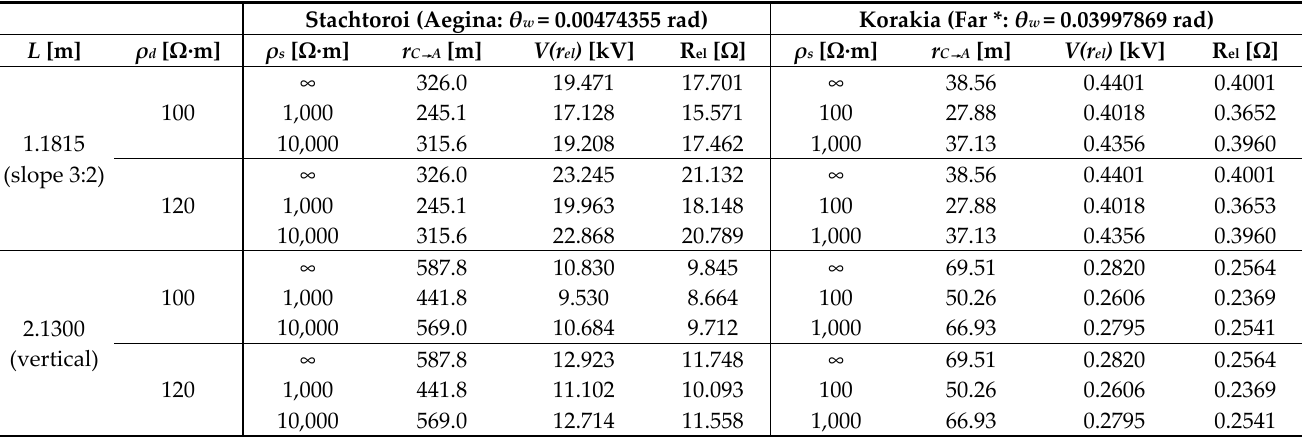
Table 8. Equalization distance of the electric field strengths between methods “A” or “B” and “C”; absolute potential on the electrode surface and equivalent electrode station resistance, in the areas of Stachtoroi, Attica and Korakia, Crete, with combined utilization of the methods under the worst-case scenario, in terms of geometric dimensions.